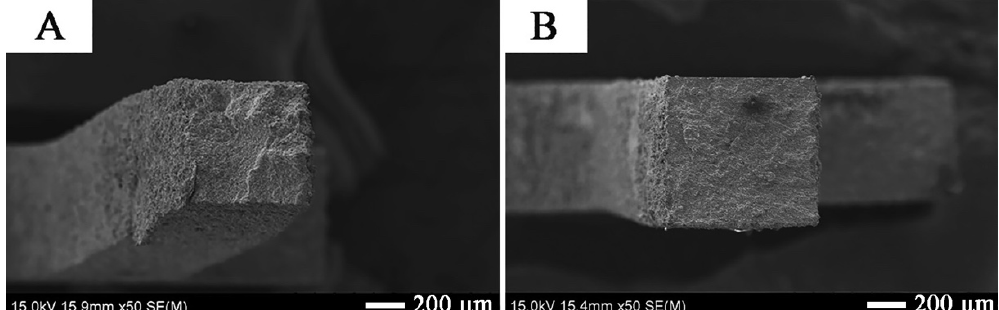
from materials obtained in the direction of the extrusion axis (“longitudinal”) and perpendicular to the extrusion axis